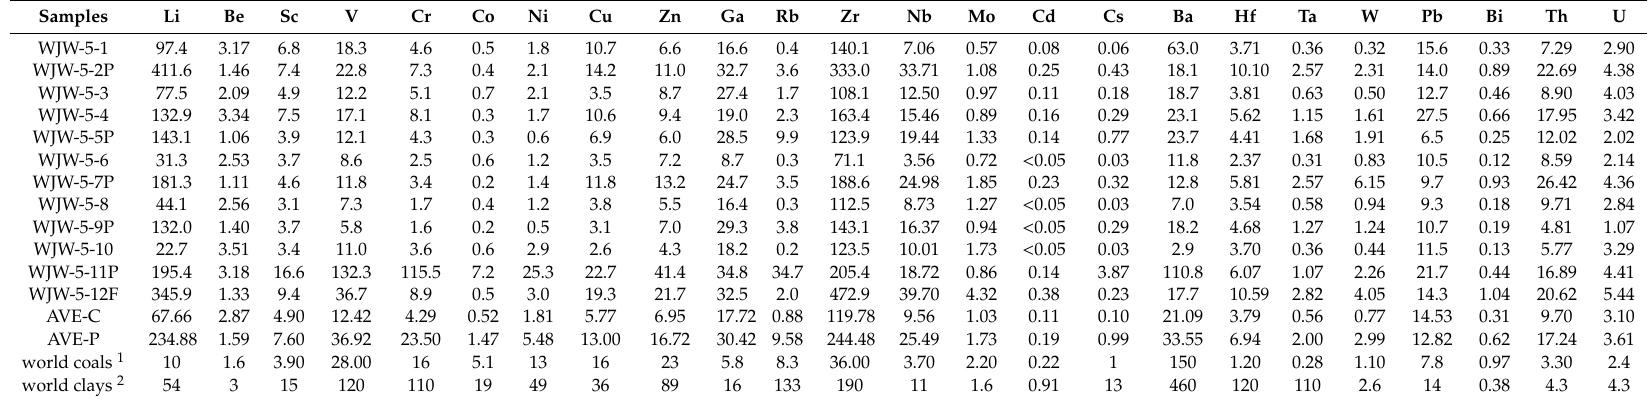
Table 3. Contents of trace elements in the No. 5 coal from the Wujiawan mine, Datong coalfield ( µ g / g, on whole coal basis).